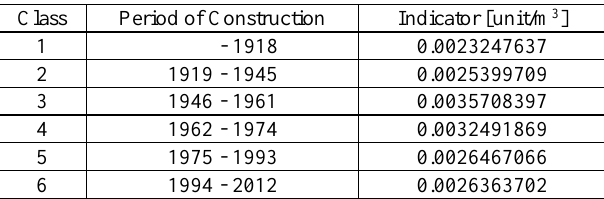
Table 2. Estimated indicators unit per building volume for the